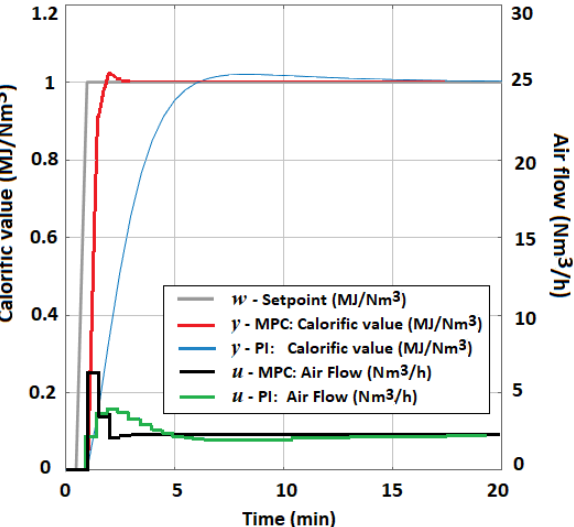
Figure 28. Comparison of calorific value stabilization by the PI controller and MPC for one setpoint.